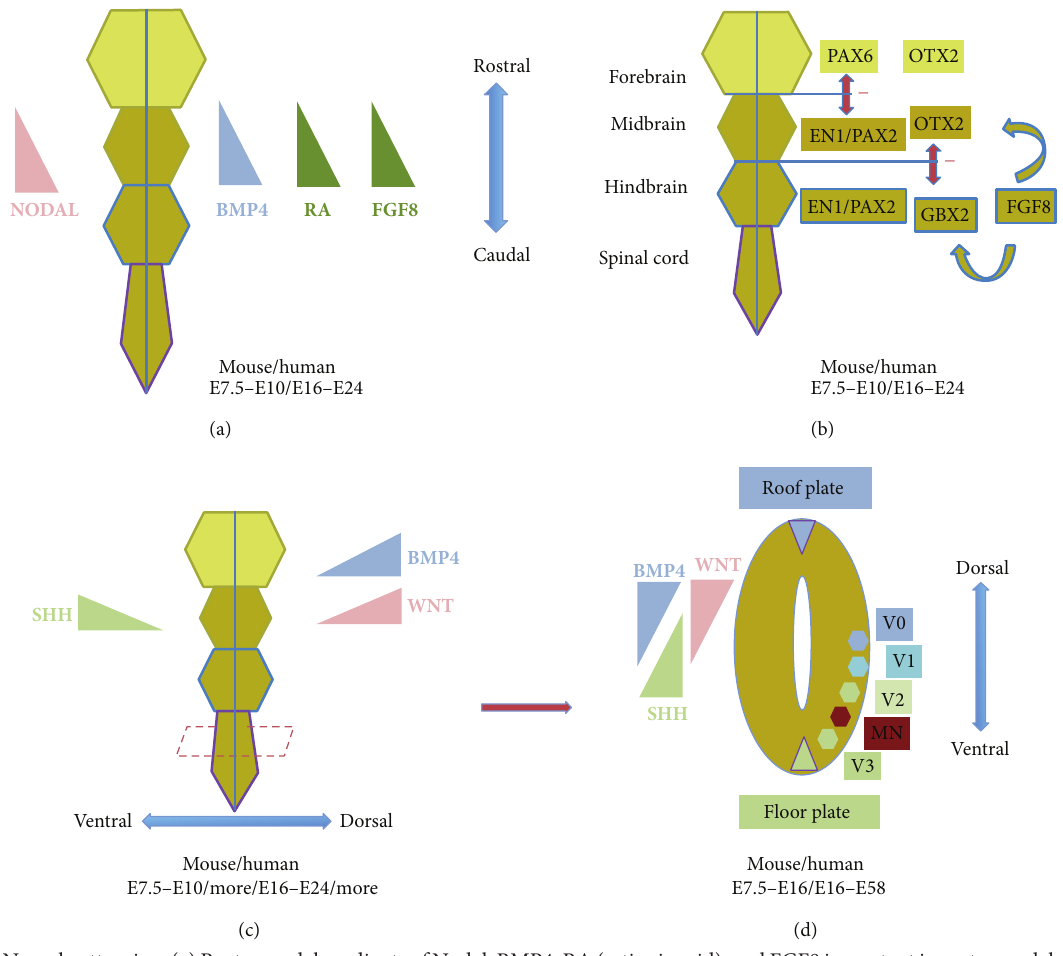
Figure 4: Neural patterning. (a) Rostrocaudal gradients of Nodal, BMP4, RA (retinoic acid), and FGF8 important in rostrocaudal patterning. (b) The interplay between different factors encoding forebrain (PAX6 and OTX2), midbrain (PAX6, OTX2, and EN1/PAX2), and hindbrain (EN1/PAX2, GBX2, and FGF8). The forebrain-midbrain barrier is defined by the mutually exclusive expression of PAX6 (forebrain) and EN1/PAX2 (midbrain), while the midbrain-hindbrain boundary by OTX2 (midbrain) and GBX2 (hindbrain). OTX2 and GBX2 are regulated by FGF8 expression. (c) Dorsoventral patterning with dorsal gradients for BMP4 and WNT and with a ventral gradient of SHH (Sonic hedgehog). (d) Transverse section through the neural tube depicting various neurons specified by the gradient of SHH from the floor plate and the BMP4 and WNT from the roof plate: V0–3: interneurons and MN: motor